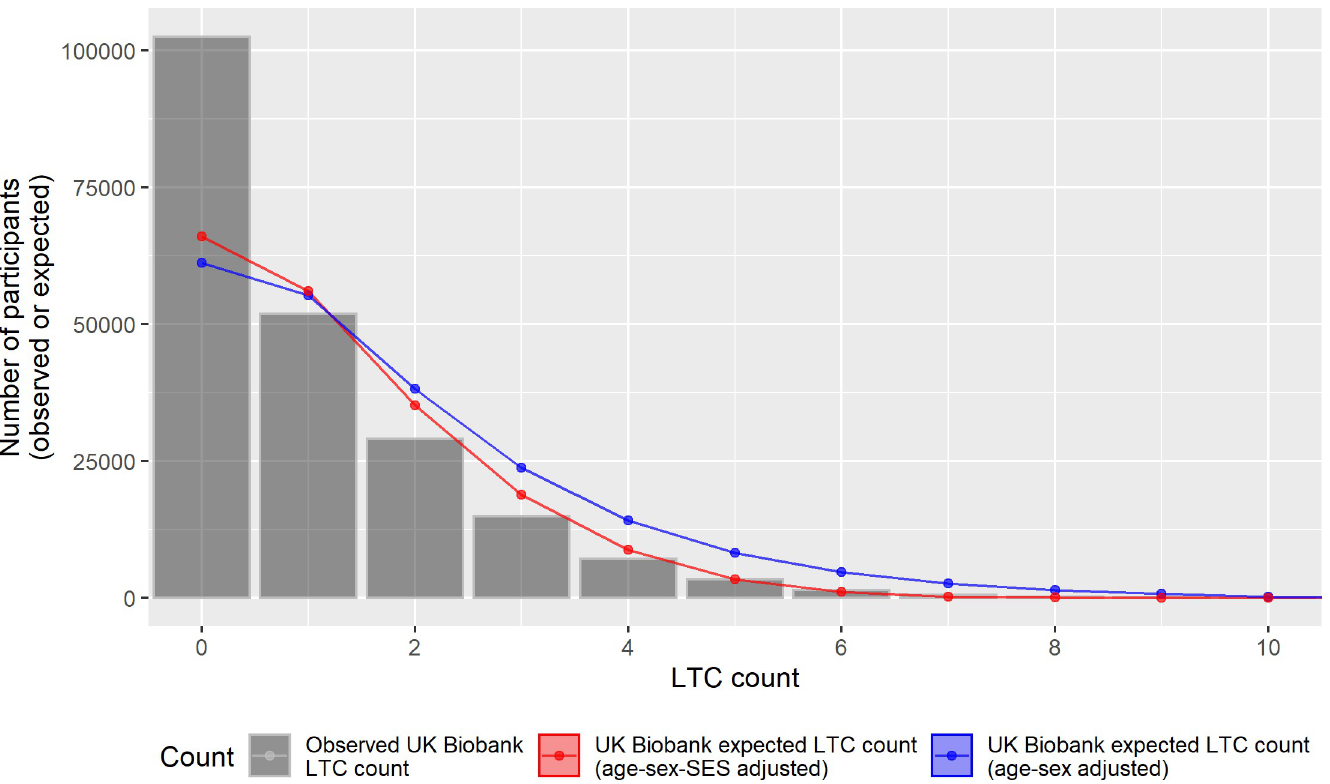
Fig 2. Observed and expected LTC counts in UK Biobank. The grey bars show the observed LTC counts in UK Biobank. The blue line shows the expected LTC counts in UK Biobank based on the age and sex adjusted regression models fitted in SAIL. The red line shows the expected LTC counts in UK Biobank based on age, sex, and socioeconomic status adjusted regression models fitted in SAIL. Observed and expected counts, with 95% confidence intervals, are also shown in S2 Table. LTC, long-term condition; SAIL, Secure Anonymised Information Linkage; SES, socioeconomic status.